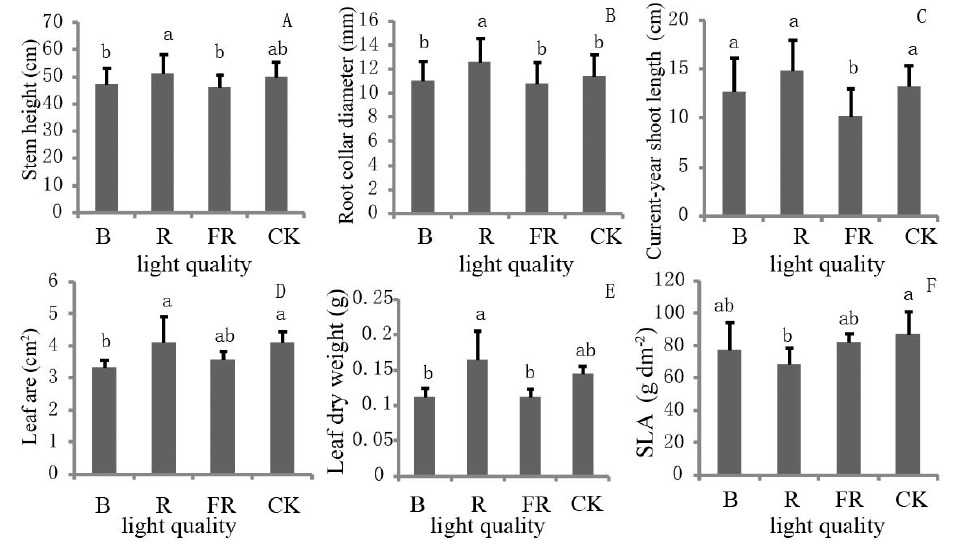
Figure 1. Multiple comparisons of stem height ( A ), ground diameter ( B ), current-year shoot length ( C ), leaf area ( D ), leaf dry weight ( E ) and the leaf area/leaf weight ratio (SLA) ( F ) of seedlings treated with blue (B), red (R), far-red (FR) and combinations of B, R and FR lights (CK). Lowercase letters, a, b, represent Duncan group.